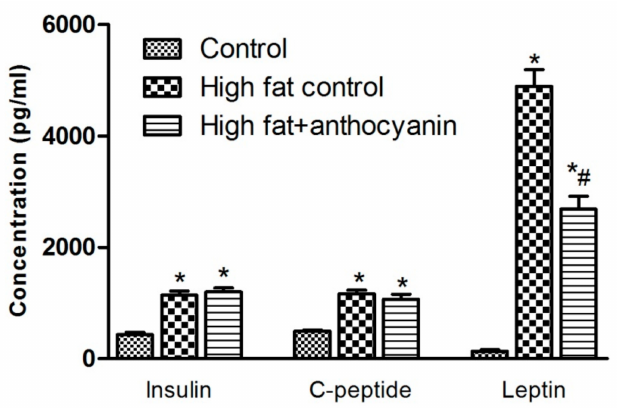
Figure 4. E ff ect of chronic anthocyanin treatment on postprandial levels of insulin, C-peptide and leptin. The * indicates significant di ff erence ( p < 0.05) from the control group. The # indicates a significant di ff erence ( p < 0.05) between the high fat control and the high fat + anthocyanin